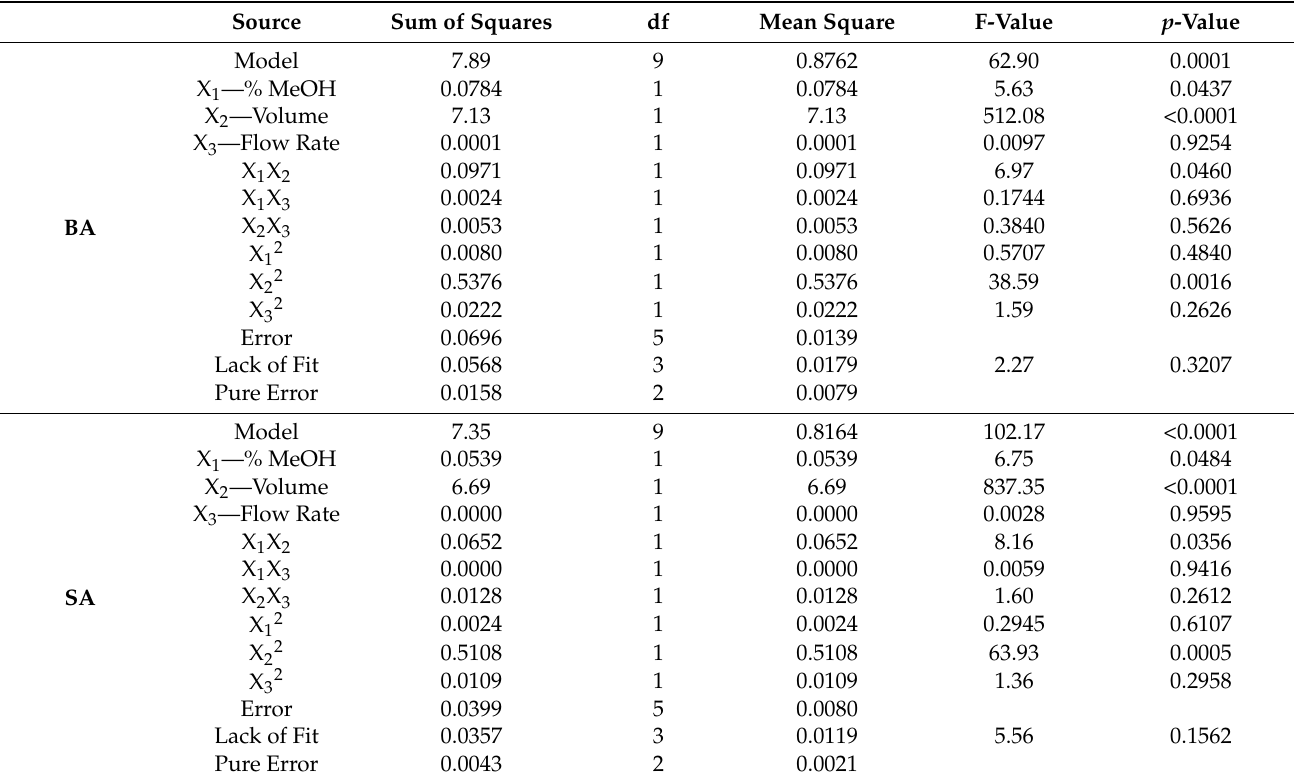
Table 6. ANOVA analysis of the SPE elution